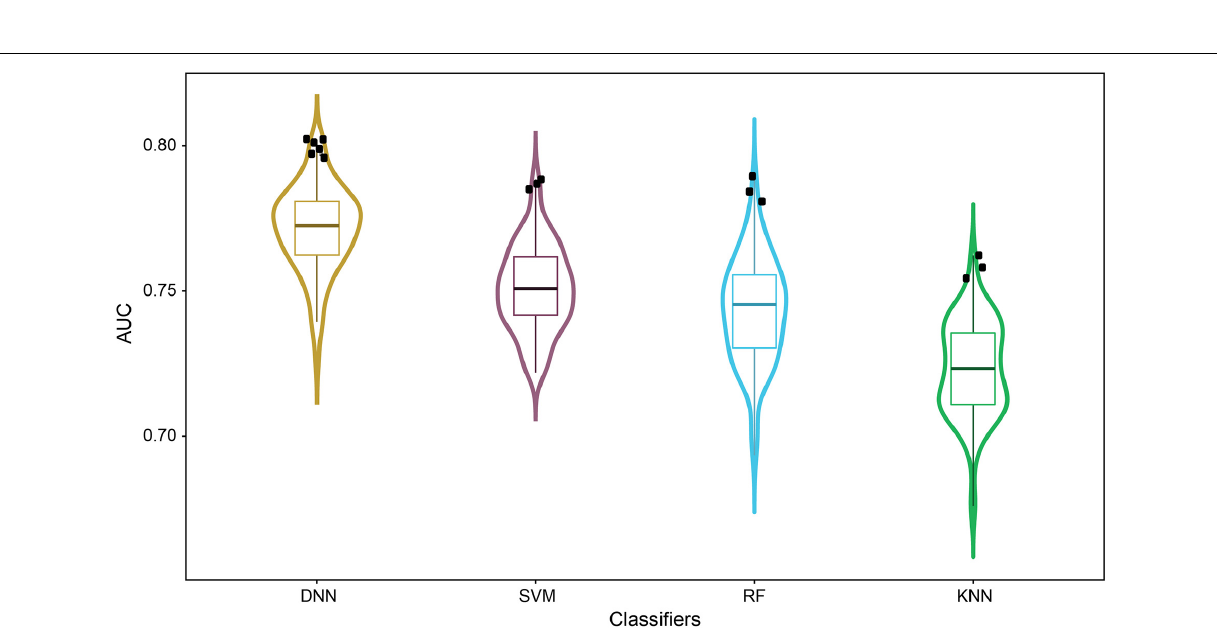
Frontiers in Bioengineering and Biotechnology | www.frontiersin.org